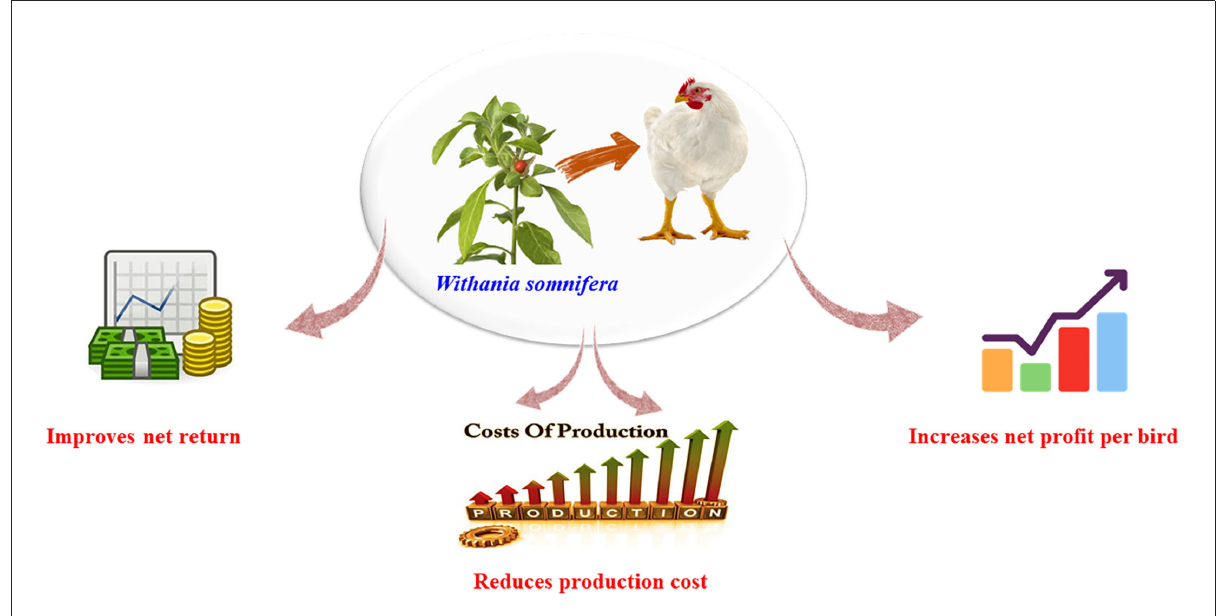
FIGURE5 Impacts of Withania somnifera supplementation on economic efficiency of